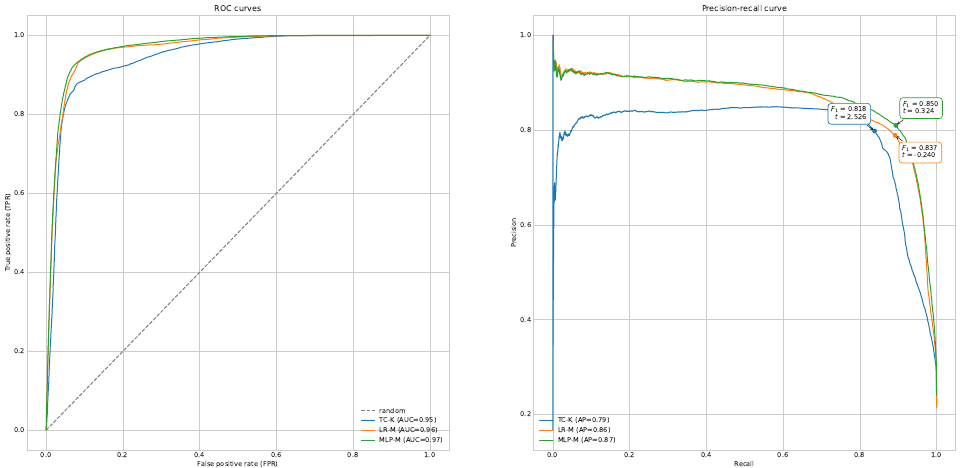
Figure 6. ROC and precision-recall curves for the best variants of TC, LR and MLP on the train- ing subset of the full dataset. The best operating points on the second plot are annotated with corresponding values of F 1 and the